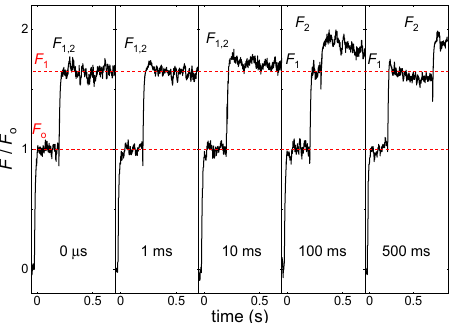
Figure 2. Kinetic traces of Chl- a fluorescence transients of DCMU-treated PSII CC of T. vulcanus at − 80 ◦ C; the traces were elicited by double STSFs fired with the indicated time intervals between the two flashes. F 1,2 marks the fluorescence levels after the double STSFs and, where resolved, F 1 and F 2 show, respectively, the levels reached after the first and the second STSF. The measurements were performed using the PAM-101 based